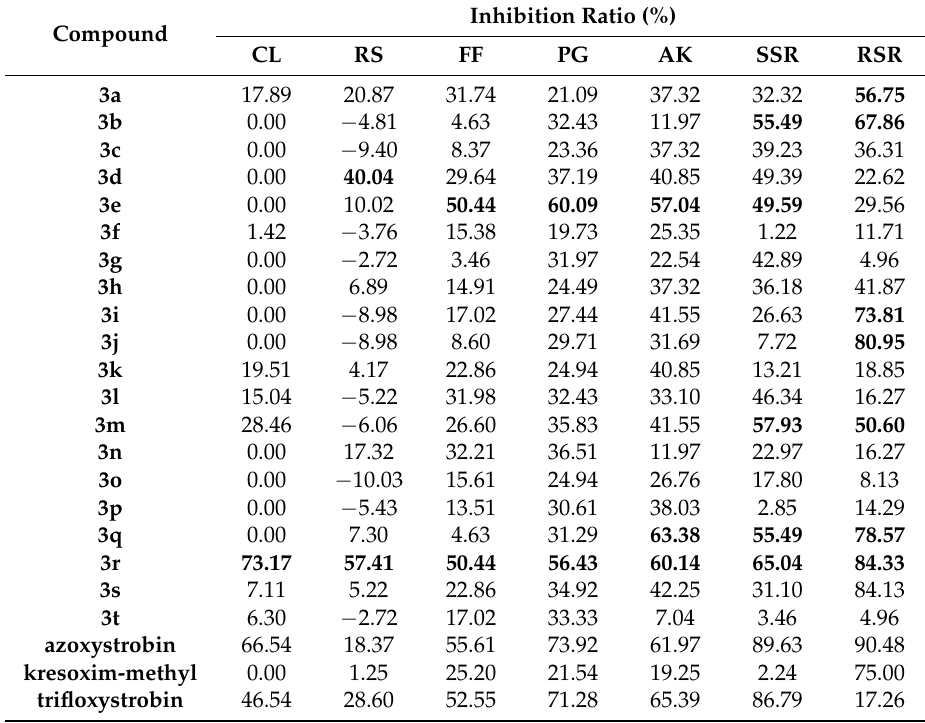
Table 2. In vitro inhibitory activity against plant pathogens at 50 μg/mL a .